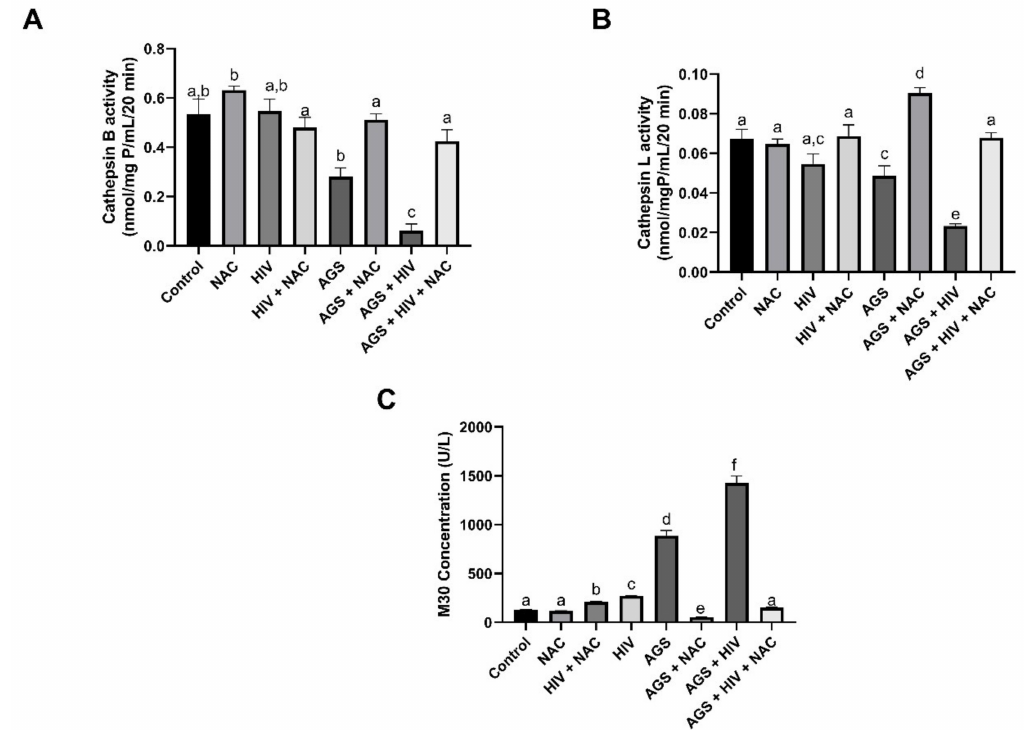
Figure 3. N-acetyl cysteine treatment prevents/reverses AGS and HIV-induced lysosomal leakage (RLW cells were treated as indicated in Materials and Methods). ( A , B ) Cathepsin B and Cathepsin L activities were measured in cell lysates (in the presence or absence of NAC) by fluorometric assay, using fluorimetric substrates. ( C ) Apoptosis was measured by M30 levels in cell culture supernatants. Data are from 3 independent experiments. Bars marked with the same letter are not significantly different from each other; bars with different letters are significantly different from each other ( p ≤